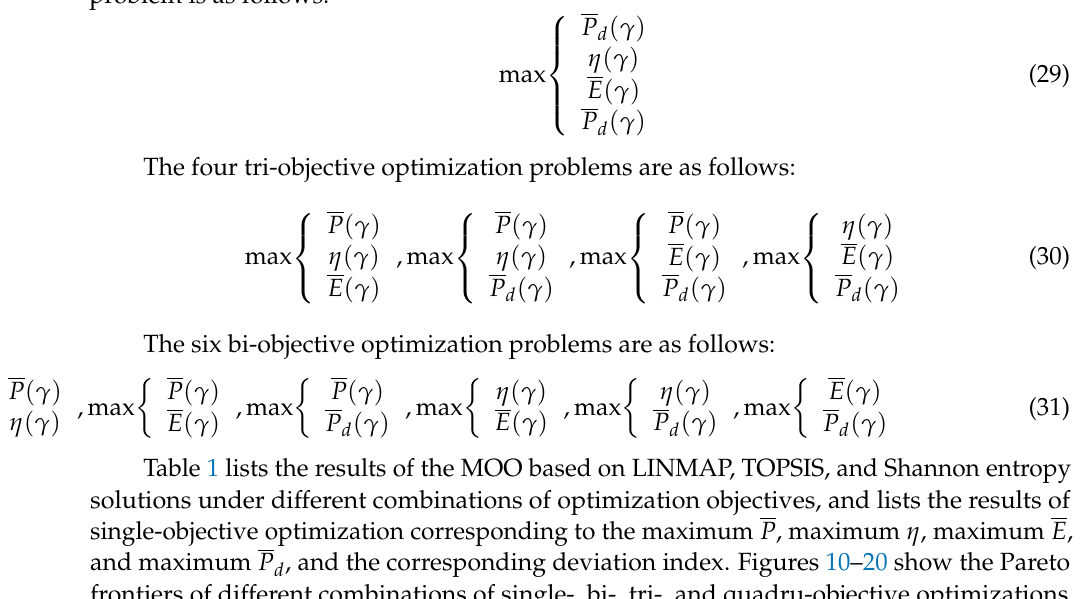
Figure 8. The curves of p 3 / p 1 versus τ .